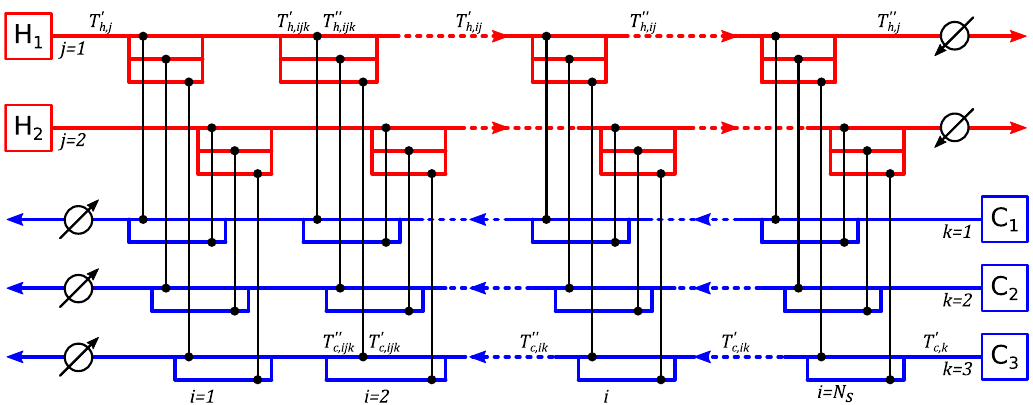
Figure 1. Stage-wise superstructure of a heat exchanger network (HEN) with two hot and three cold process streams.